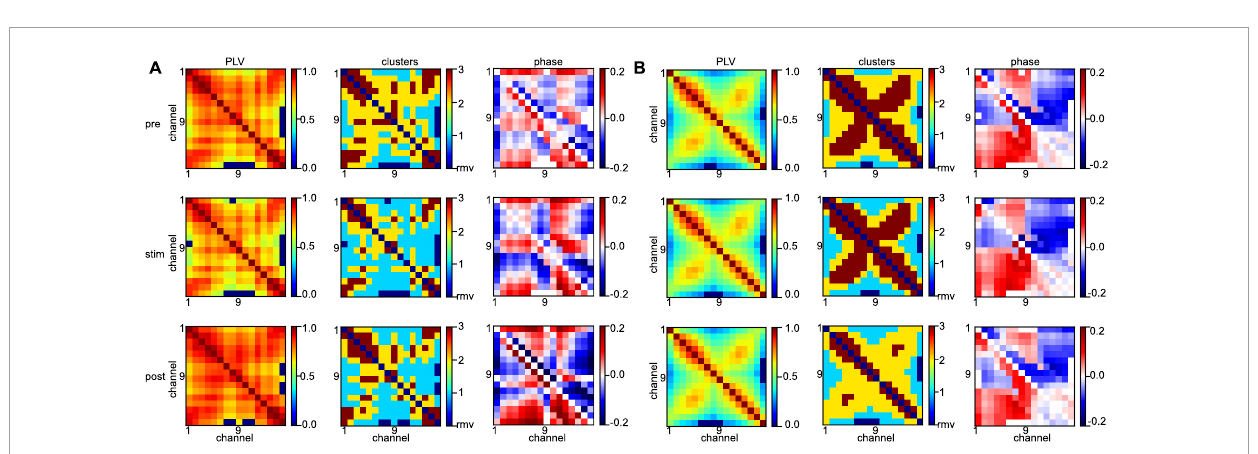
FIGURE9 Different network synchronization in slow oscillations and γ -band activity. (A) Connectivity maps (left column), synchronization clusters C1 (cyan), C2 (yellow), and C3 (red) of channel pairs (center column), and phase differences between channels (right column) before stimulation (top row), during stimulation (center row), and after stimulation (bottom row) in slow oscillations. (B) Connectivity maps, synchronization clusters and phase differences in the three stimulation conditions in γ -band activity. Data has been taken from subject